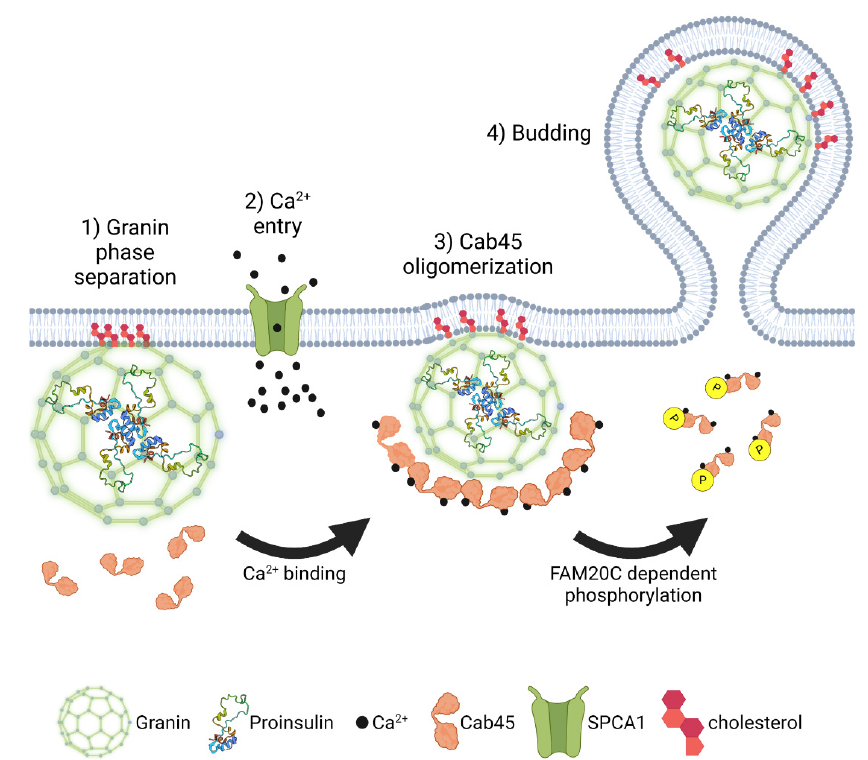
Figure 6. Proinsulin granule export from the TGN. Granin proteins self-assemble into multimeric macromolecular structures, which selectively capture proinsulin and other secretory granule cargo through a process referred to as liquid phase separation. As the condensate coalesces, granin proteins interact with the Golgi membrane at cholesterol-rich lipid rafts. SPCA1-mediated Ca 2+ influx drives oligomerization of Cab45 and further condensation of granin-proinsulin complexes. Following nutrient stimulation or other signals, disruption of Cab45 oligomers through FAM20C-mediated phosphorylation promotes proinsulin vesicle budding and exit from the TGN. Images were created using Biorender.